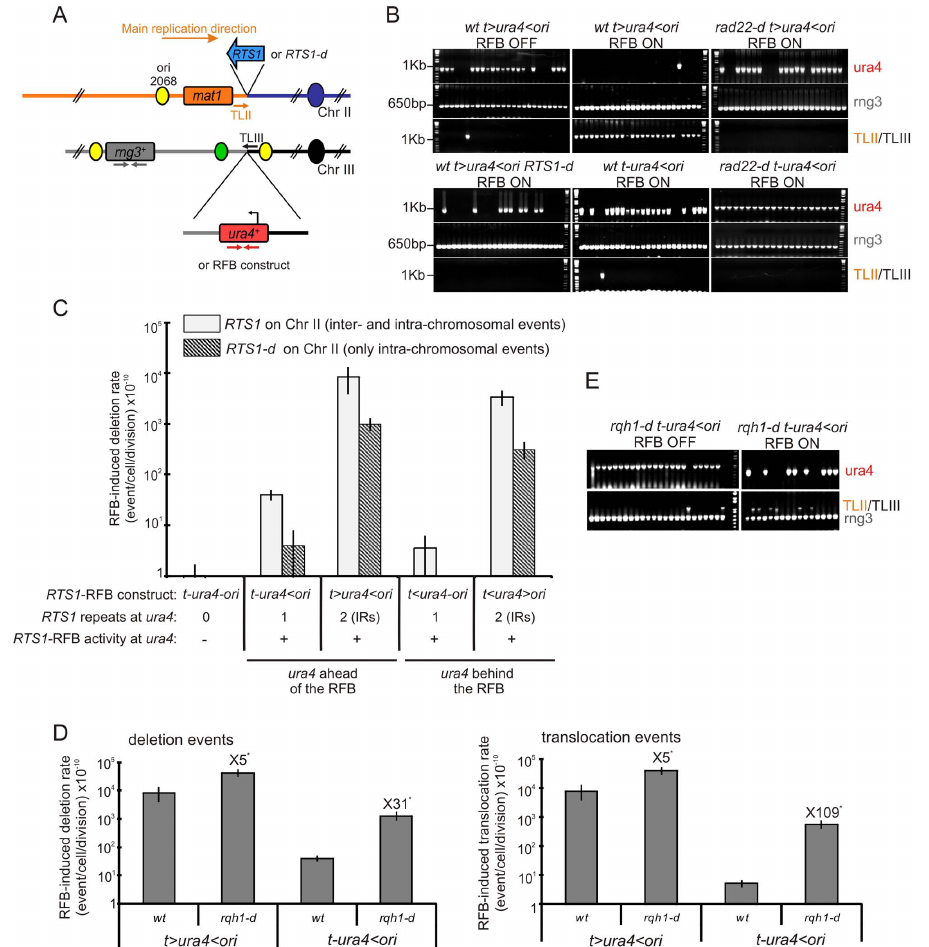
Figure 2. A single fork-arrest induces GCRs that are stimulated by inverted repeats near the site of fork arrest. A. Diagrams of chromosome II containing or not the RTS1 sequence (blue arrow or RTS1-d ) and of chromosome III containing ura4 + alone or associated with RTS1- RFB constructs. The RTS1 sequence maps near the mat1 locus where it helps to ensure unidirectional replication [62]. Primers used for amplifying the 1 Kb ura4 fragment or the 650 bp rng3 fragment are depicted in red and grey, respectively. Primers used to amplify the translocation junction (1.2 kb) are represented in orange on chromosome II (TLII) and in black on chromosome III (TLIII). B. Representative PCR-amplifications from 5-FOA R colonies of the indicated strains; ON and OFF refers to the RTS1 -RFB being active or not, respectively. PCR products and their sizes are indicated on the figure. C. Effect of intra- and inter-chromosomal recombination between RTS1 repeats on fork-arrest-induced genomic deletion. RTS1 -RFB activity and ura4 location with respect to the RFB are given for each construct. The % of deletion events, as determined by the PCR assay, was used to balance the rate of ura4 loss. Then, the RFB-induced deletion rate was calculated by subtracting the rate obtained in the presence of thiamine (Rtf1 being repressed) from the rate obtained in the absence of thiamine (Rtf1 being expressed). The values reported are means of at least 3 independent median rates. Error bars correspond to the standard error (SE). D. Effect of Rqh1 on RFB-induced deletions (left) and translocations (right), as described for panel C. Error bars indicate SE. Statistically significant fold differences between the rqh1-d and the wild-type strains are indicated with an *. E. Representative PCR amplifications from 5-FOA R colonies of the rqh1-d t-ura4 , ori strain, as described for panel B. (Refer to Figure S1 for corresponding rates of deletion and translocation when Rtf1 is expressed or